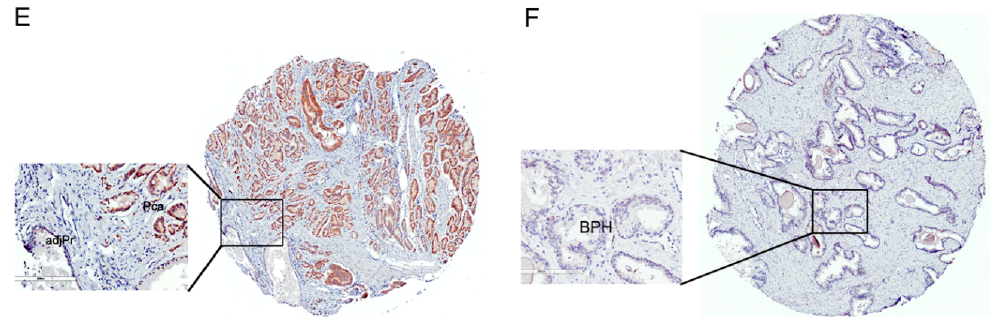
Figure 1. Phosphorylated (p)-Akt expression levels in representative primary prostate cancer (PCa) and non-neoplastic prostate tissues. Tissue microarrays (TMAs) of primary PCa and non-neoplastic prostate (benign prostatic hyperplasia; BPH) tissues were immunohistochemistry (IHC) analyzed for p-Akt. ( A ) Patient with a weak p-Akt expression level (intensity score 1 × extent score 1 = p-Akt image score 1); ( B ) Patient with T2cN0M0 cancer, a Gleason score of 3 + 4 = 7, and a moderate p-Akt expression level (intensity score 2 × extent score 3 = p-Akt image score 6); ( C ) Patient with T2cN0M0 cancer, a Gleason score of 4 + 3 = 7, and marked p-Akt immunostaining in the cytoplasm (intensity score 2 × extent score 4 = Snail image score 8); ( D ) Patient with T2cN0M0 cancer and a Gleason score